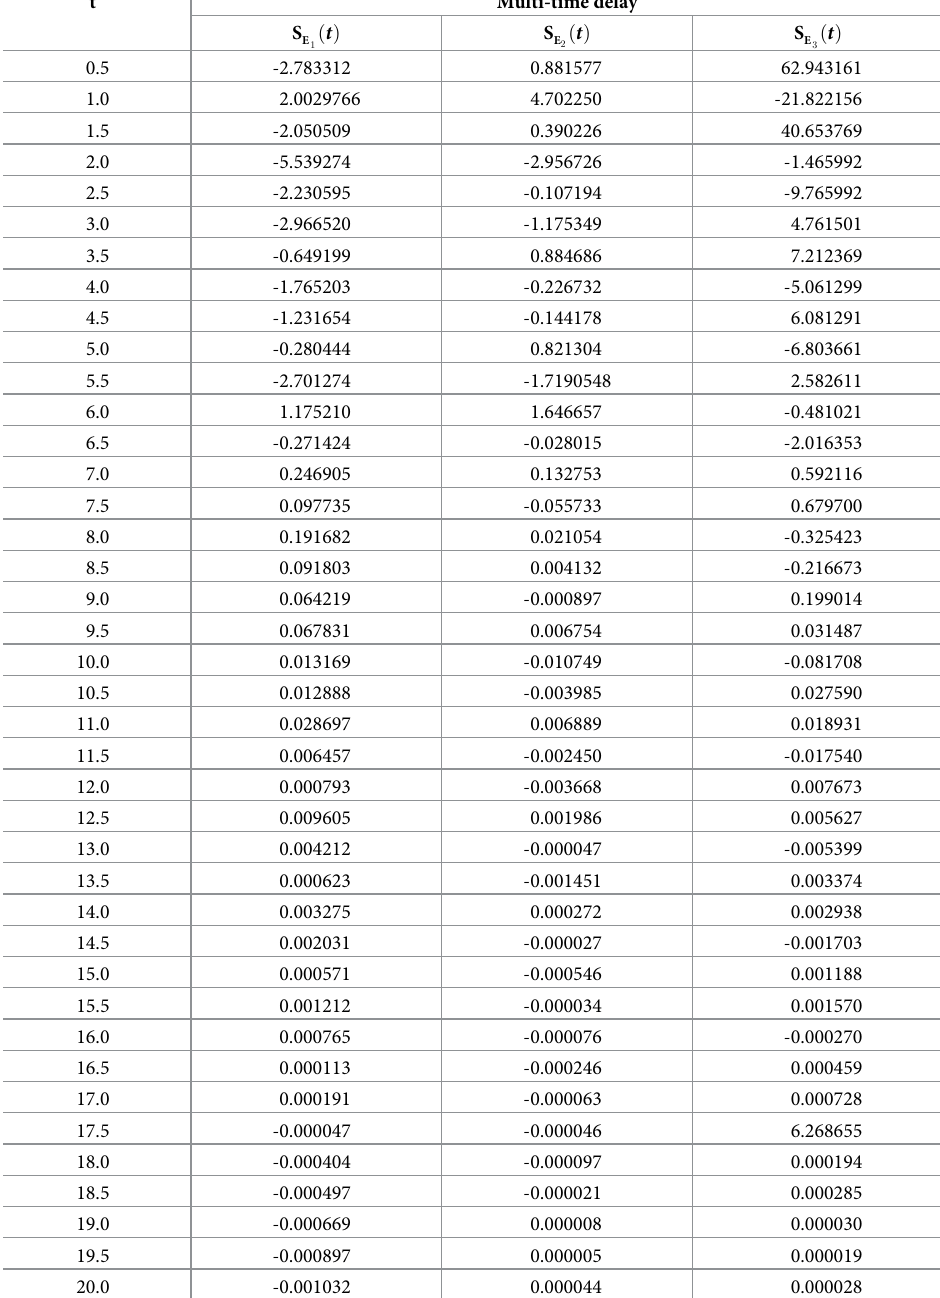
Table 3. Time for error dynamics to converge to zero for the multi-FONNSMD system with multi-time